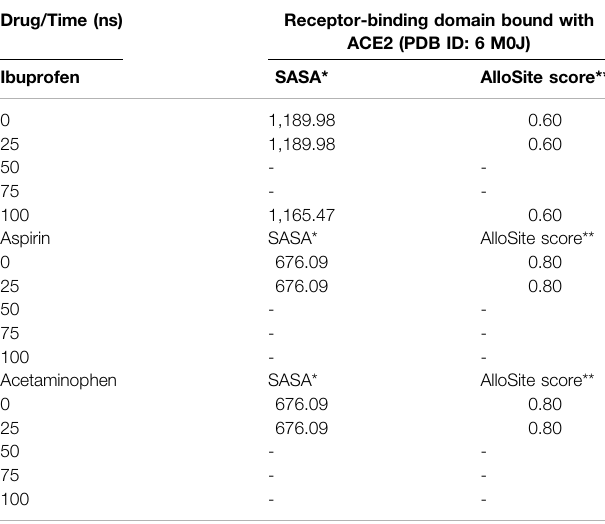
*All the cavity values are expressed in Volume Hull (Å 3 ). PockDrug-Server was used applying the Fpocket method; Cavity_1, Cavity_2 and Cavity_3, they representthe main cavities1,2and3,respectively.Orderedbyvolume.1isthelargest,followedby2and3.; Cavity_mean,representstheaveragevalueofthevolumeofthemaincavities1,2and3, respectively.; # Cavity, represents the total number of cavities predicted for the complex at each time.